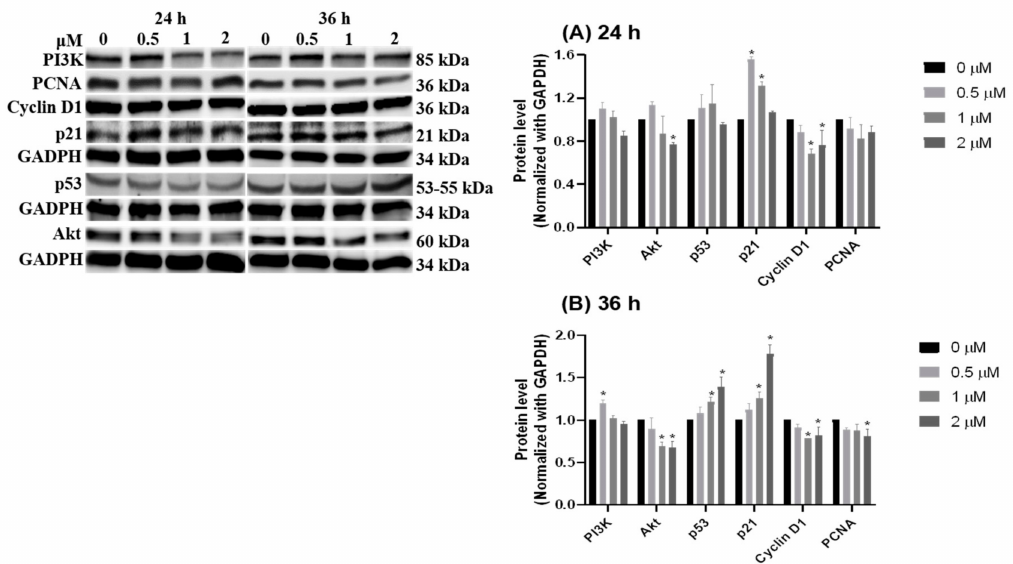
Figure 6. Dynamics of cell growth related signaling pathway after HCD treatment. Caco-2 cells were treated with HCD and the changes in PI3K, Akt, p53, p21, cyclin D1, and PCNA were measured at ( A ) 24 h and ( B ) 36 h. The protein levels were represented as the ratio of GAPDH-normalized chemiluminometric intensity between the untreated control (0 µ M) and treatment. Data ( n = 3) were represented as mean ± SD. * p < 0.05 as compared with the untreated control (0 µ